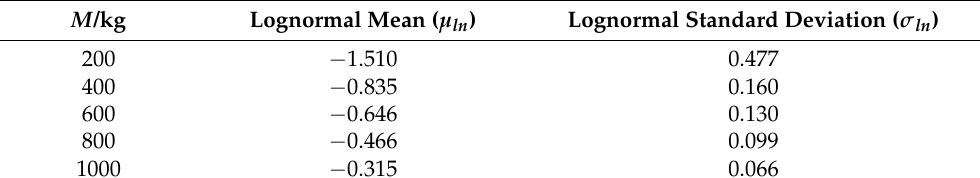
Table 14. Lognormal mean and standard deviation under different equivalence of explosives.